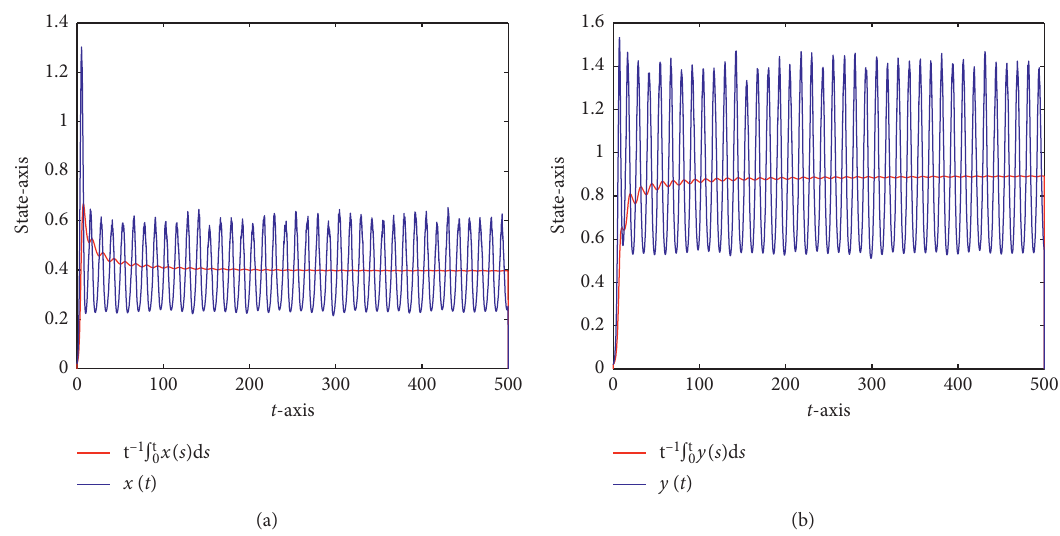
Figure 2: Permanence in the mean of (5) with n � 1 and x ( 0 ) � y ( 0 ) � 0 . 02. (a) The permanence in the mean of x . (b) The permanence in the mean of y